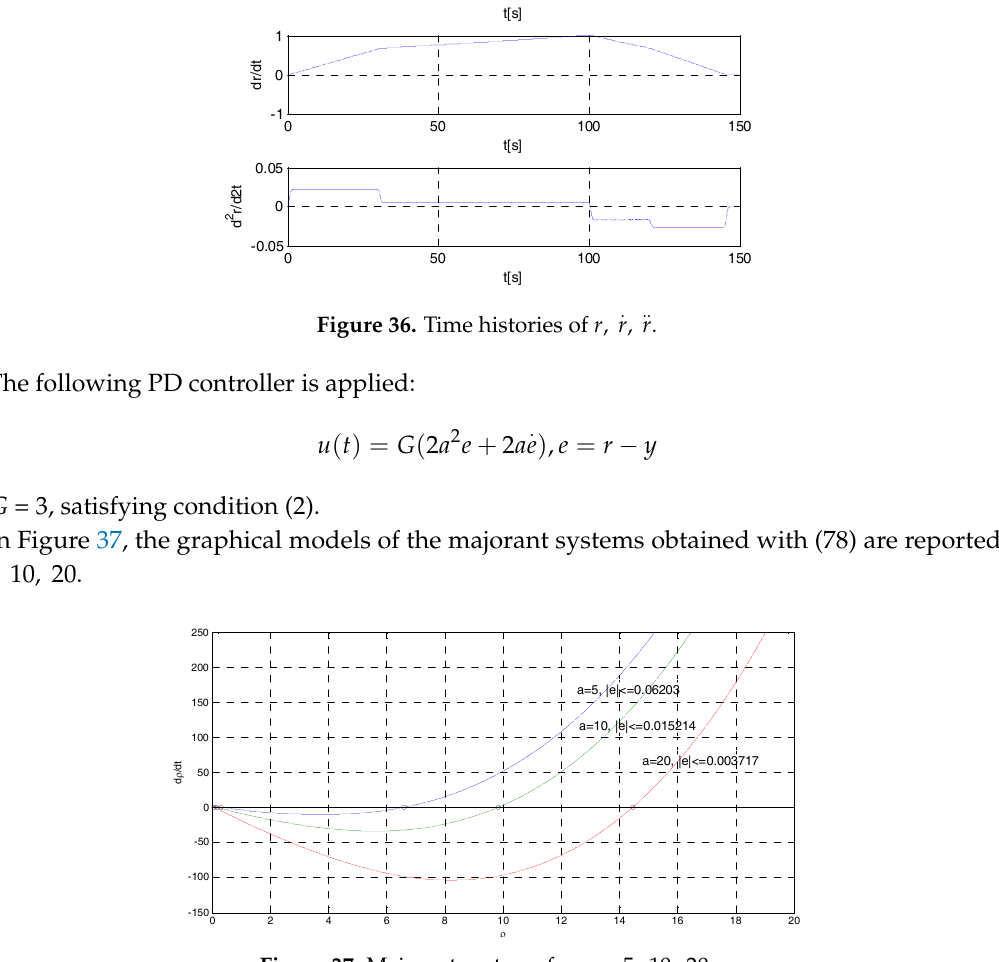
Figure 37. Majorant systems for a = 5, 10, 20.